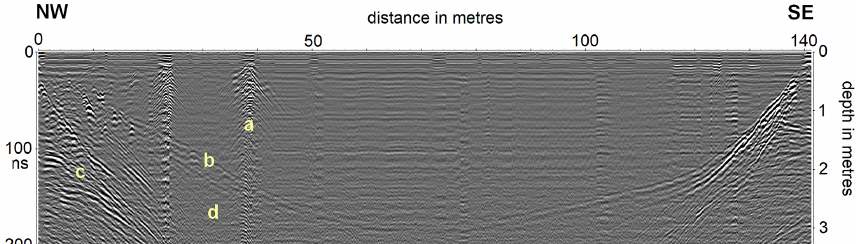
Figure 2. GPR reflection profile across Lake Młynek (see Fig. 2): (a) drilling M1, (b) upper boundary of the so-called hard bottom, (c) strat- ified glaciofluvial sandy-gravel beds beneath the lake sediments, (d) attenuation zone of electromagnetic waves connected with occurrence of organic sediment (gyttja) (measurements, processing and interpretation: Fabian